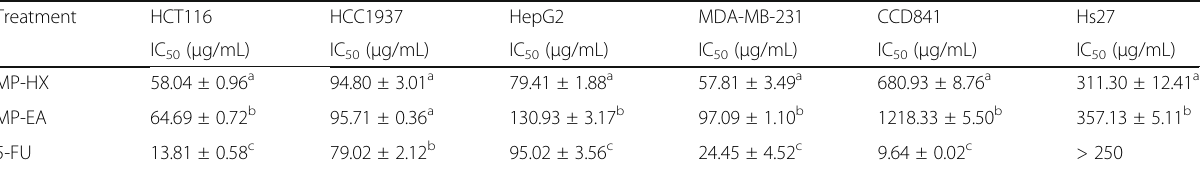
Values are mean ± SD ( n = 3). Mean values in each column with different letters (a, b and c) are significantly different ( p <